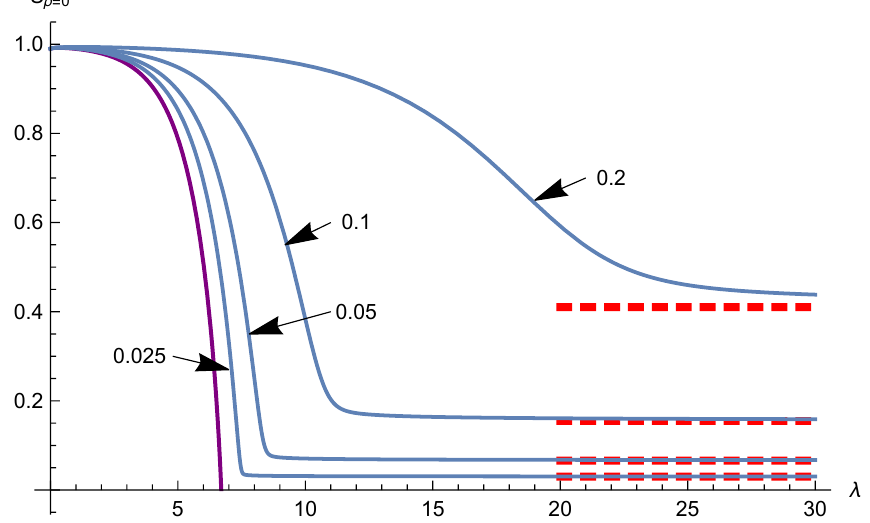
Figure 8 . Figure showing curves of S evaluated at the horizon, ρ = 0 , against flow time for magnetic flows of perturbed magnetic RN which initially decrease the horizon size. This shows how the (square of the) horizon radius flows. The purple curve is the uncharged case, where the horizon shrinks to a singularity at finite flow time, λ ∼ 6 . 7 . The other curves show charges given by r − = 0 . 025 , 0 . 05 , 0 . 1 and 0 . 2 . We see that for all these charges the horizon asymptotes to the stable one for that charge and surface gravity (the values of S for the stable black hole are shown as red dashed lines and are computed from equation (5.22)). As the charge is decreased, the curves become more similar to the uncharged case until the point that the horizon settles on that of the smaller stable black hole